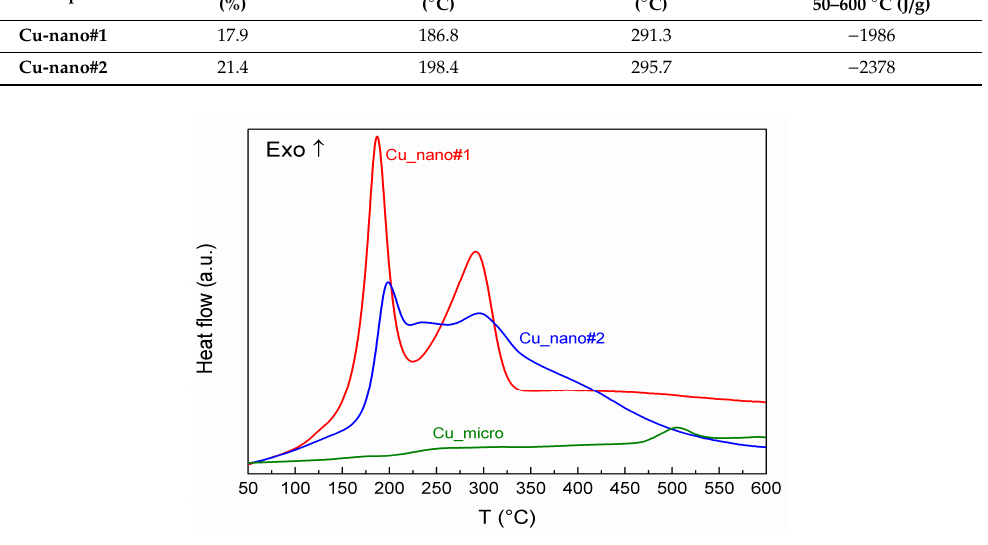
Figure 4. DSC of Cu-nano#1, Cu-nano#2 and Cu-micro. Table 3. Results of DSC (final temperature 600 °C).